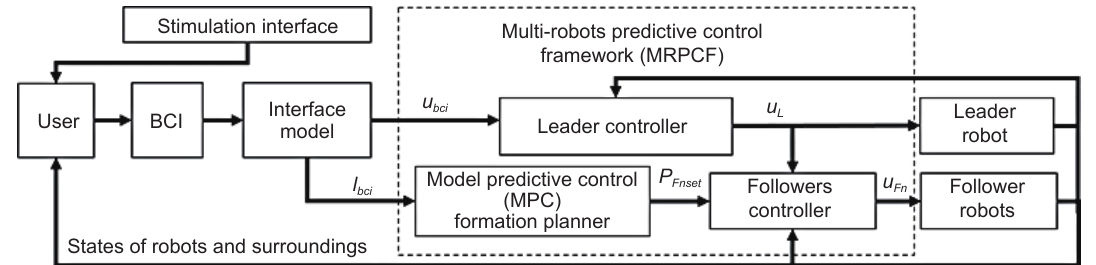
Fig. 1 Architecture of the proposed brain-controlled multi-robot